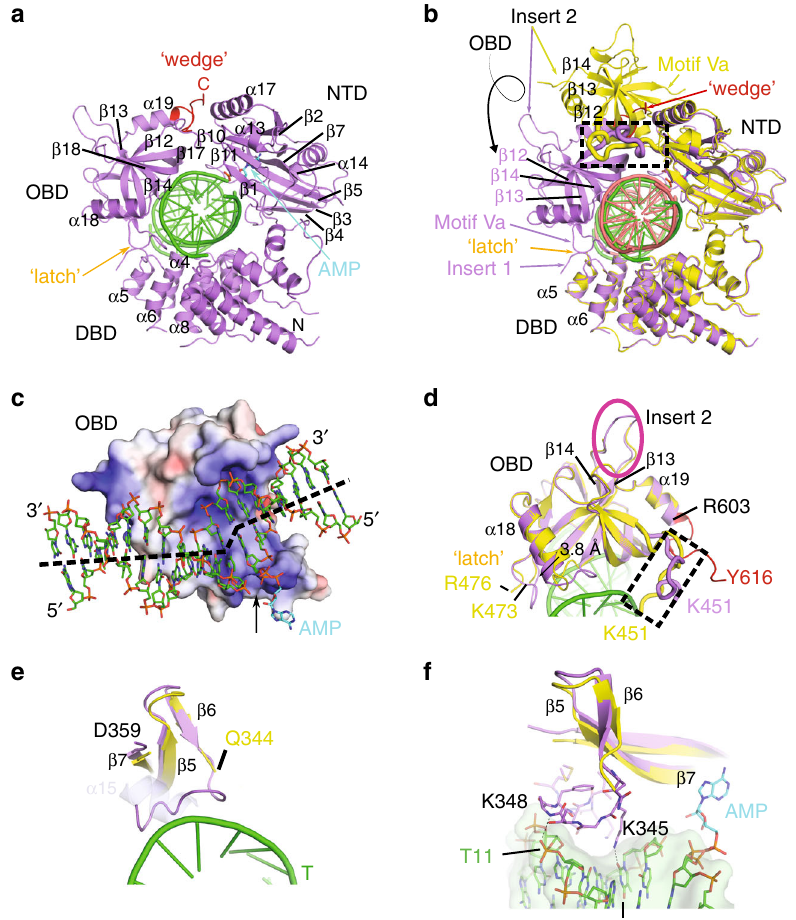
Fig. 3 The DNA – adenylate complex adopts a catalytically competent closed conformation. a Ribbon diagram of the LigIV catalytic domain (purple) bound to a nicked DNA substrate (green), where the adenylate group (cyan) has been covalently transferred from Lys273 to the 5 ′ -phosphate on the downstream strand. The complex is viewed down the axis of the DNA helix. b Superposition of the open lysyl-adenylate (protein in yellow, DNA in pink) and closed DNA – adenylate (protein in purple, DNA in green) complexes of LigIV. The hinge region is marked with a black dashed box. During the open to closed transition, the OBD domain undergoes a complex “ swivel-and-close ” motion to encircle the DNA, the direction of which is indicated by the spiral arrow. Secondary structural elements in ribbon diagrams are labeled as in Supplementary Fig. 3. The ordered region of the C-terminal tail in the closed DNA – adenylate complex is shown in red and the ‘ latch ’ is indicated in orange. c Rendering of the electrostatic surface of the OBD subdomain in the closed conformation, with the bound nicked DNA – adenylate substrate (DNA in green, adenylate in cyan). The electrostatic surface potential was calculated using the Adaptive Poisson – Boltzmann Solver tool in PyMOL 50 , which ranges from − 6 kT e − 1 (electronegative, red) to 6 kT e − 1 (electropositive, blue). Regions of neutral charge are shown in white. The nicked DNA substrate (green) with the 5 ′ -adenylate (cyan) is drawn in stick. The nick junction is indicated by a black arrow. The trajectories of the upstream and downstream duplex are indicated by a dashed black line. d , e Detailed aspects of conformational differences between the open (yellow) and closed (protein in purple, DNA in green) conformations in the OBD subdomain ( d , linker between NTD and OBD delineated by a black dashed box, and Insert 2 by a magenta oval) and the loop between β 6 and β 7 ( e ). α 15 observed in the apoprotein structure (PDB ID 3W5O 20 ) is drawn transparently in gray. f Detailed view of the interactions of the β 6- β 7 connecting loop with the DNA substrate. Putative hydrogen- bonding interactions with the DNA substrate are shown as black dashed